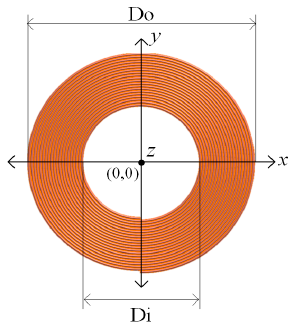
Figure 5. Circular, flat spiral, air-core single coil geometry. Table 1. Coil parameters.